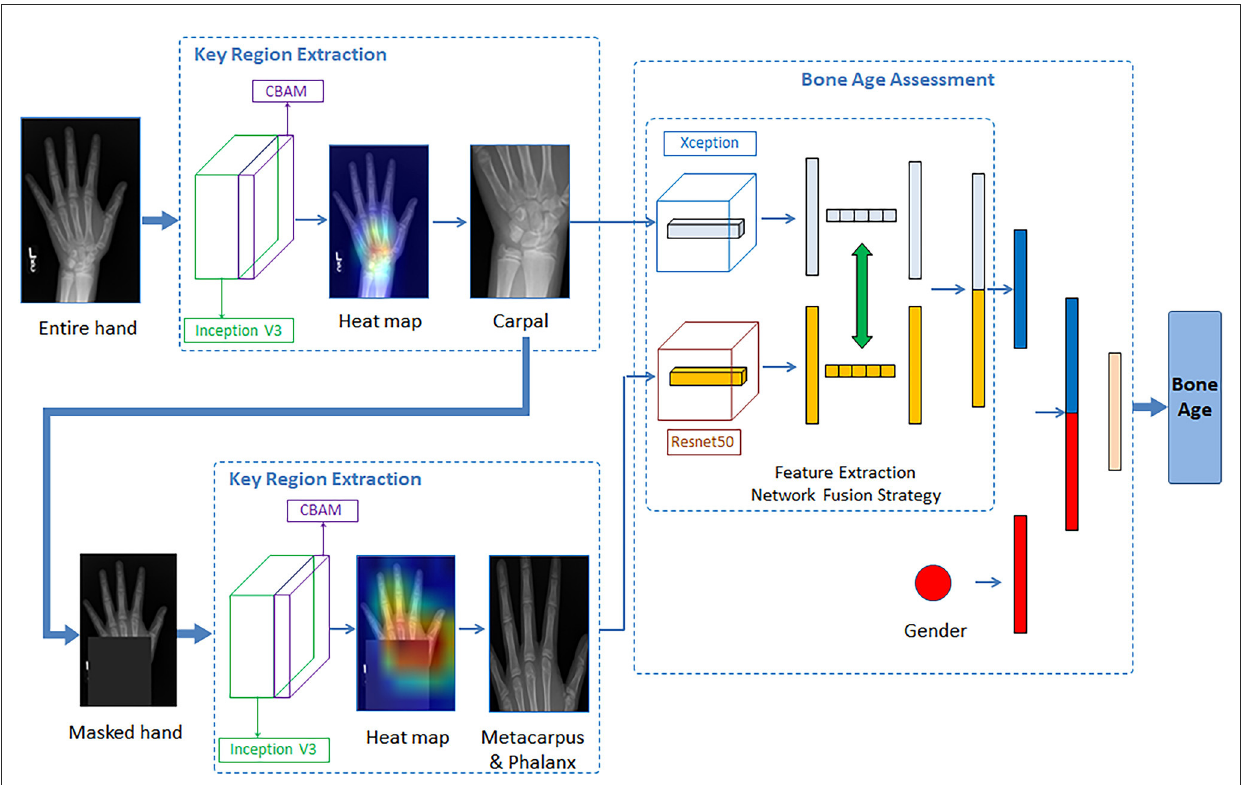
FIGURE2 Illustration of the proposed network architecture for the